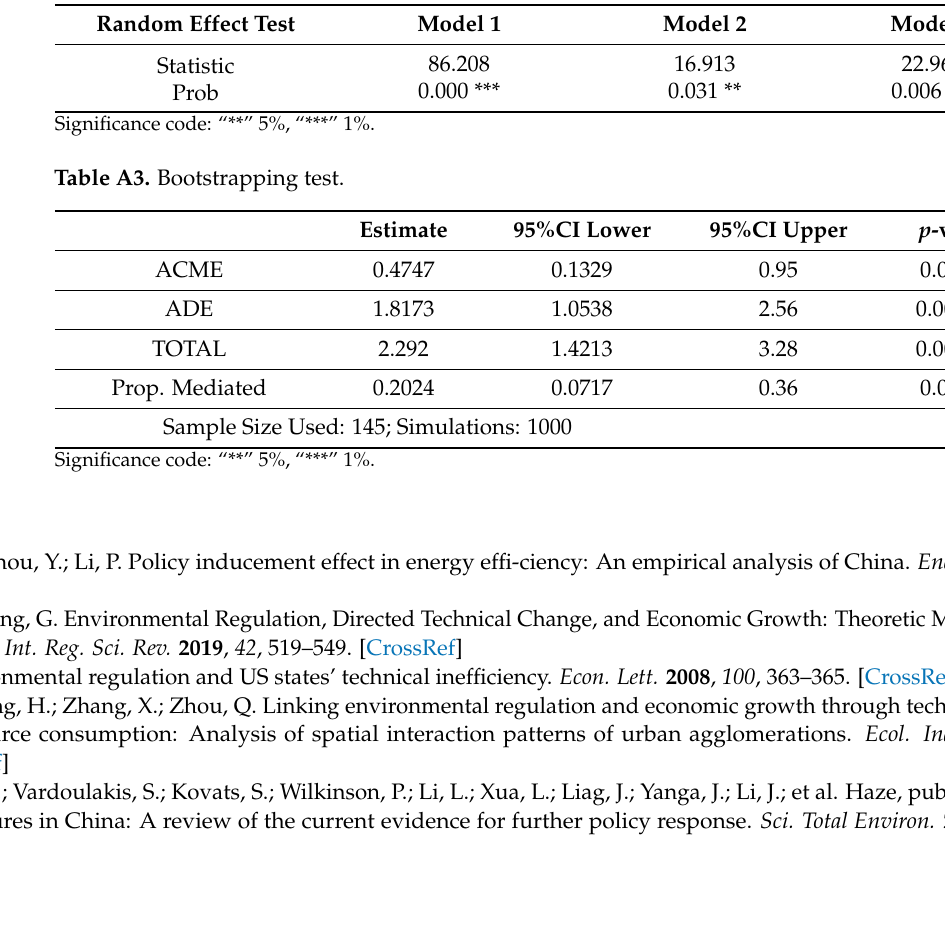
Table A2. Hausman test.